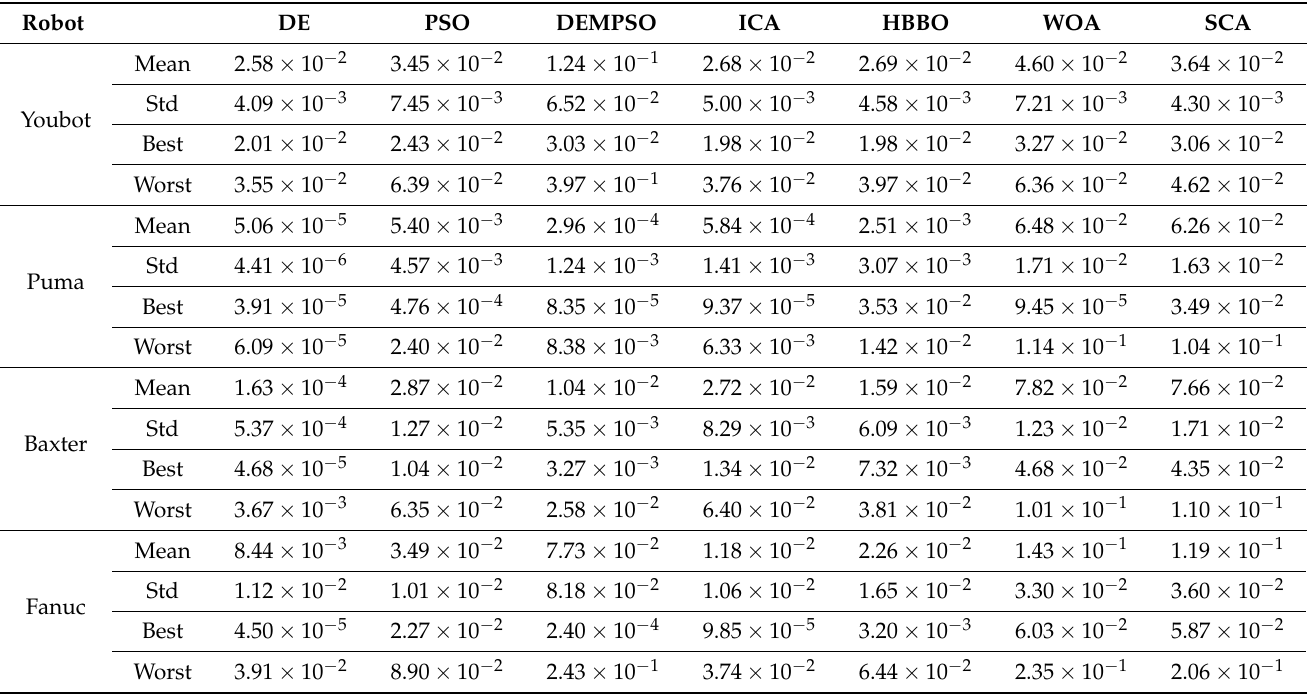
Table 10. Objective function comparative results for lemniscate